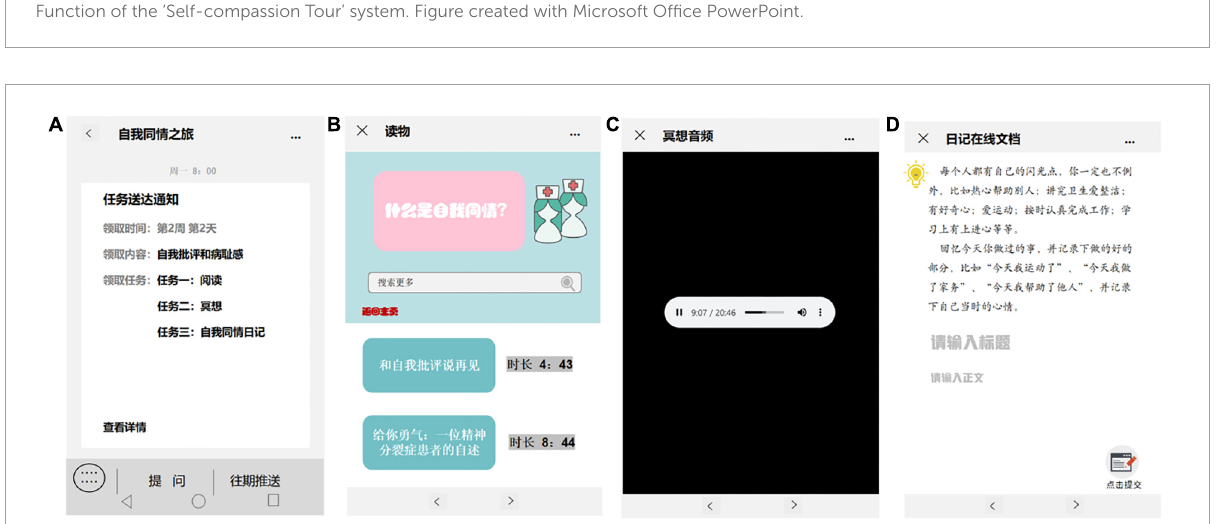
FIGURE3 The interface of the ‘Self-compassion Tour’. (A) Notification of new messages, (B) reading task, (C) meditation task, (D) self-compassion journal task. Figure created with Microsoft Office PowerPoint.